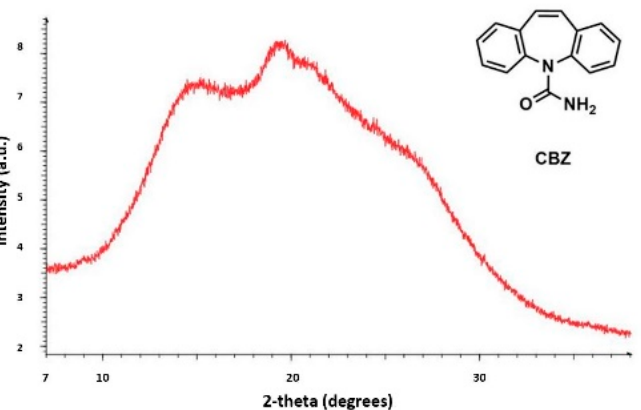
Figure 8. Powder X-ray diffraction (PXRD) patterns from a conventional X-ray source of the amorphous